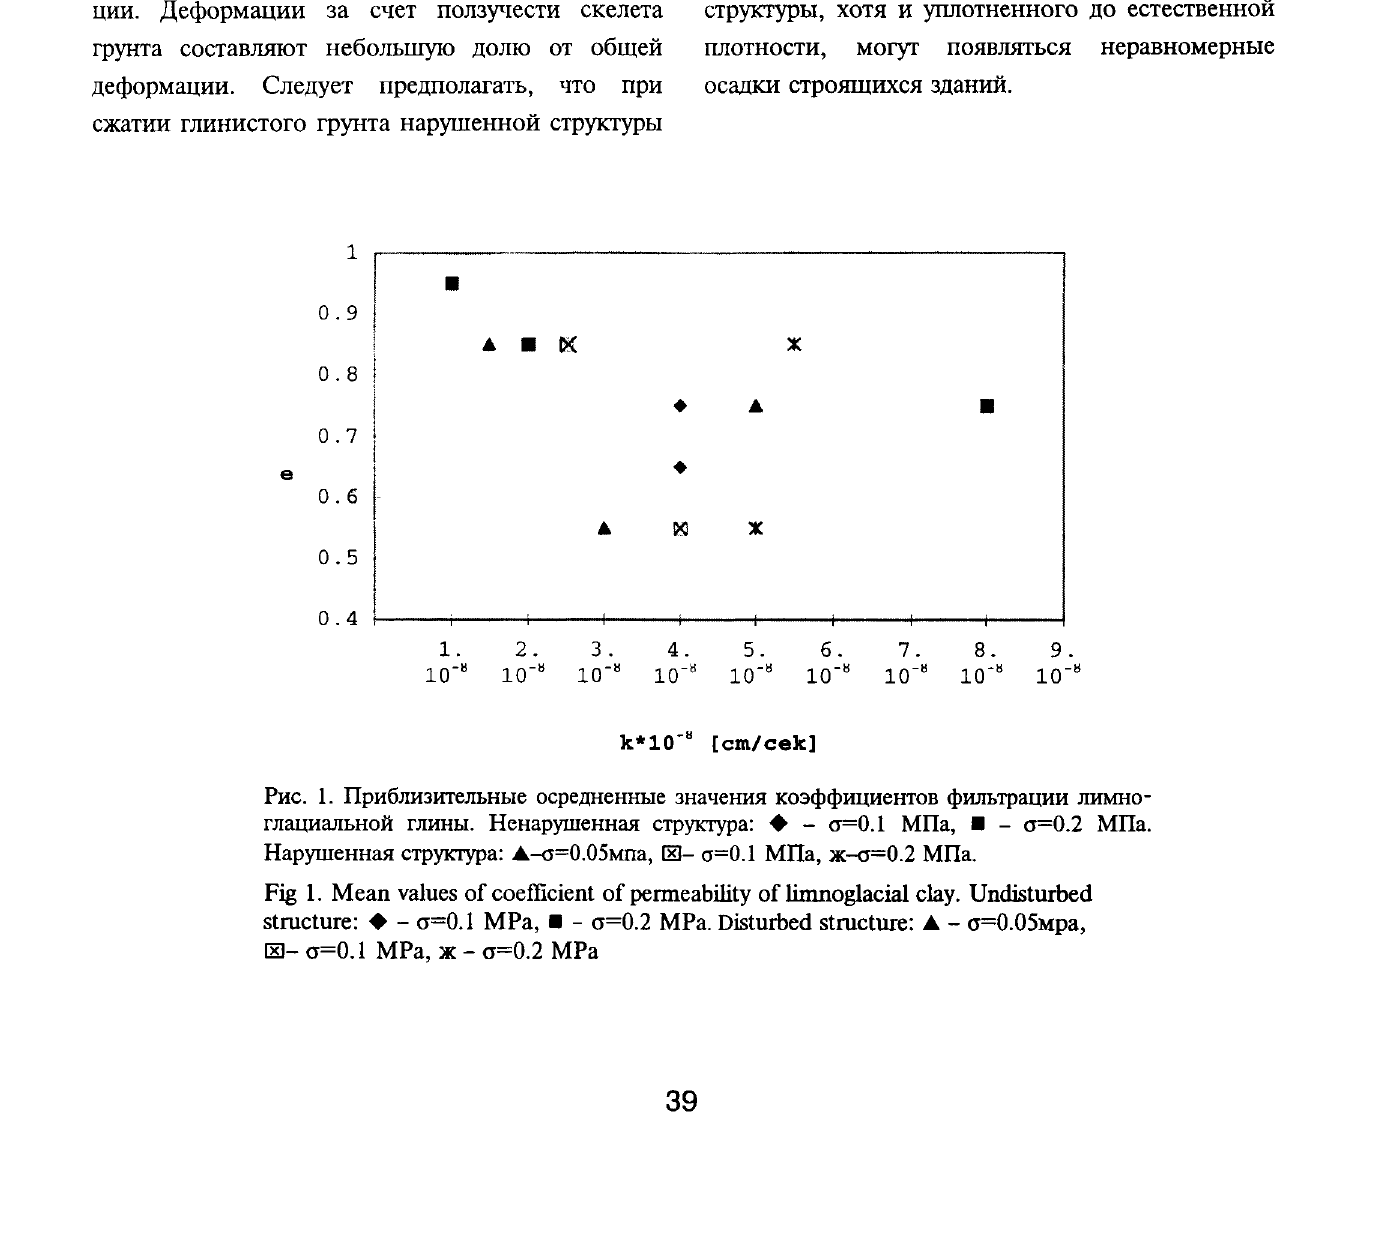
Fig 1. Mean values of coefficient of permeability of limnoglacial clay.